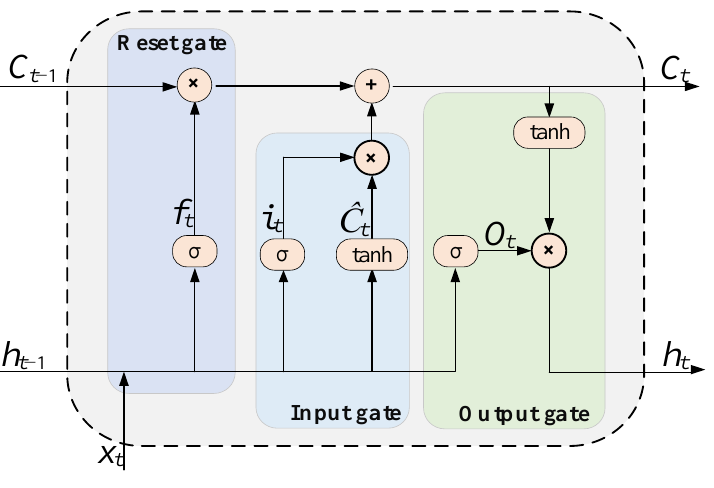
Figure 2. Architecture of LSTM.